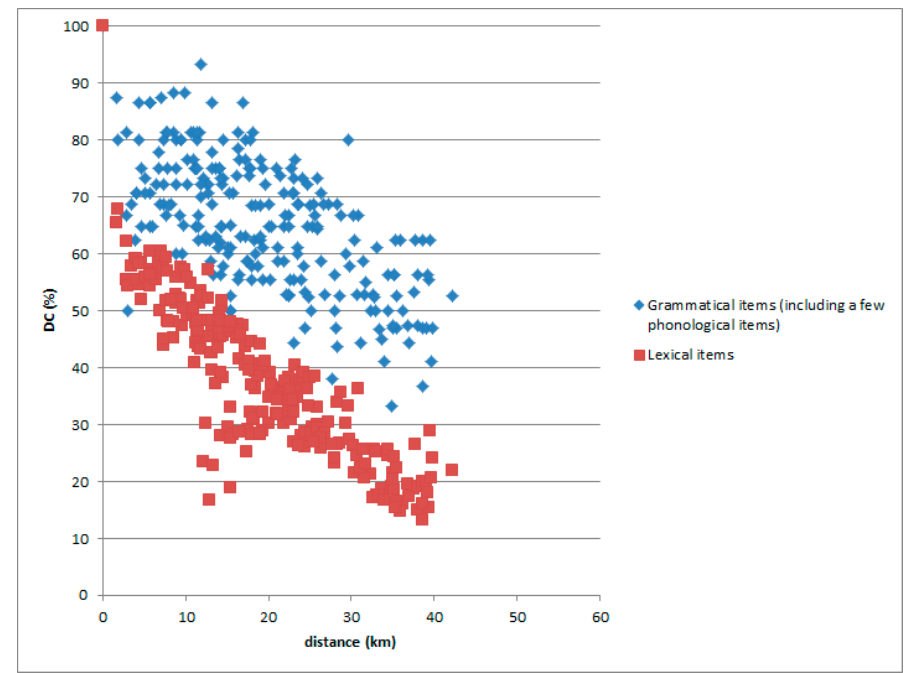
Figure 23. Lexical and grammatical items of the Kamiina-no Hogen data with reference place in Minowa.